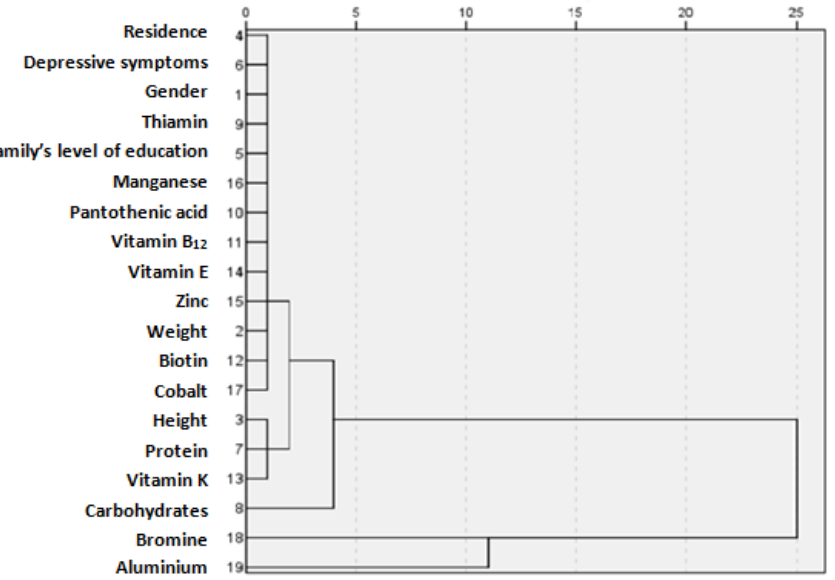
Figure 1. Hierarchical cluster: dendrogram using depressive symptoms in schoolchildren per demographic characteristic and nutrient intake.